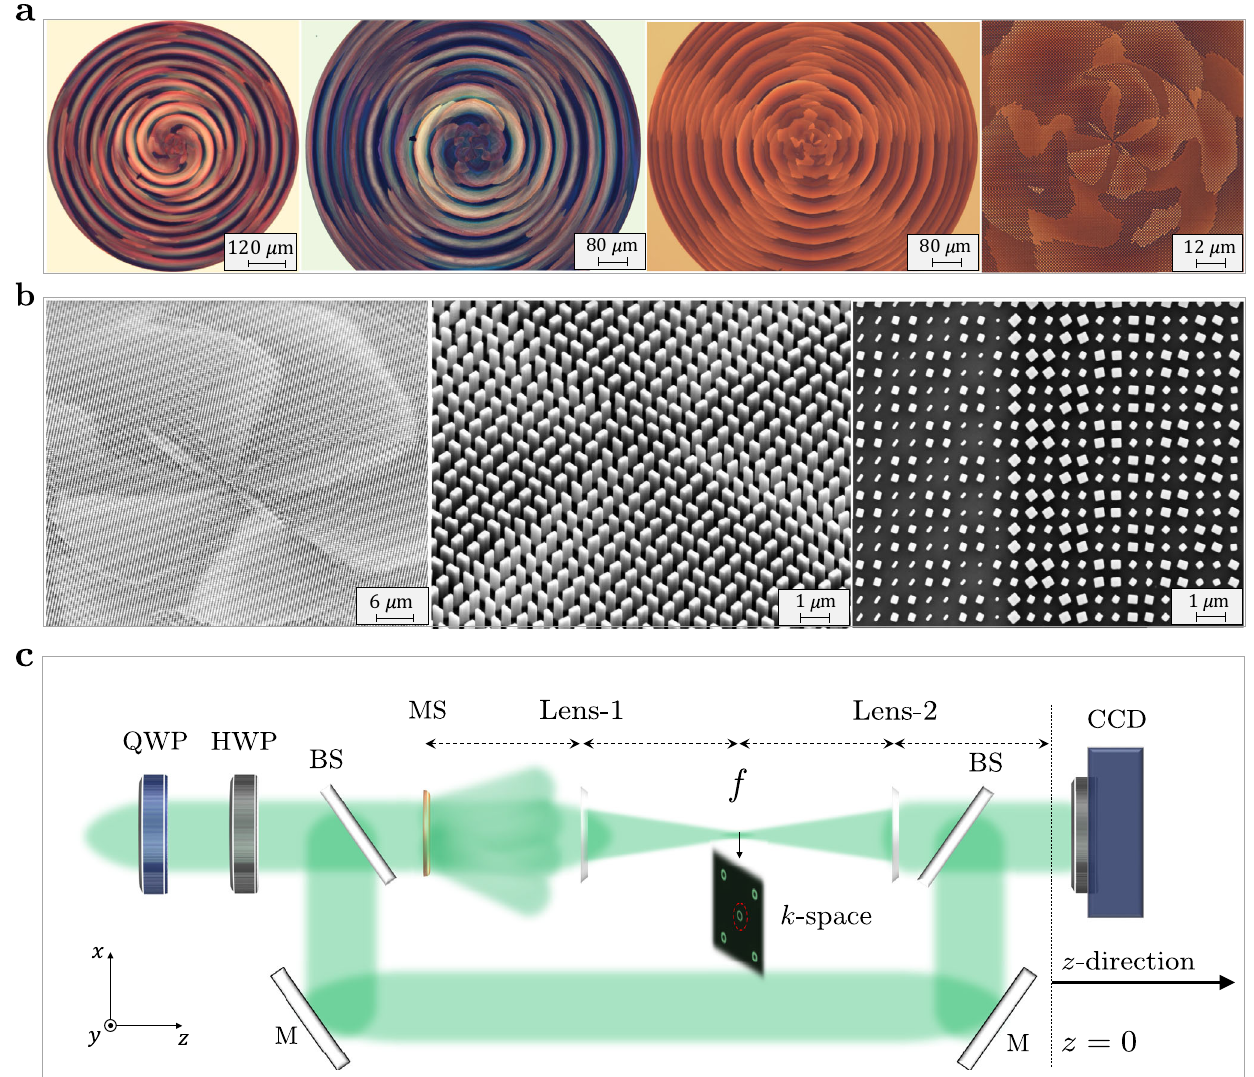
Fig. 2 Fabricated devices and experimental setup. a Optical microscope images of sample fabricated TAM plate devices exhibiting a fl ower petal-like structure. b Scanning electron microscope (SEM) images verifying the smooth sidewall pro fi le of the individual nano fi ns. The checkerboard-like pattern observed in the nano fi n orientations signi fi es the underlying dual-matrix holography (DMH) implementation; each element of the target dual-matrix hologram is realized on the metasurface by four nano fi ns. c Experimental setup (top view) used to characterize the devices: a quarter-waveplate (QWP) and half-waveplate (HWP) control the polarization of the beam incident on the metasurface (MS). The output response is fi ltered and imaged using a 4- f system ( f = 5 cm) onto a charge-coupled device (CCD) camera. An interferometric setup, comprising beam splitters (BS) and mirrors (M), is deployed to interfere each vortex beam with a tilted Gaussian beam to characterize its z -dependent topological charge